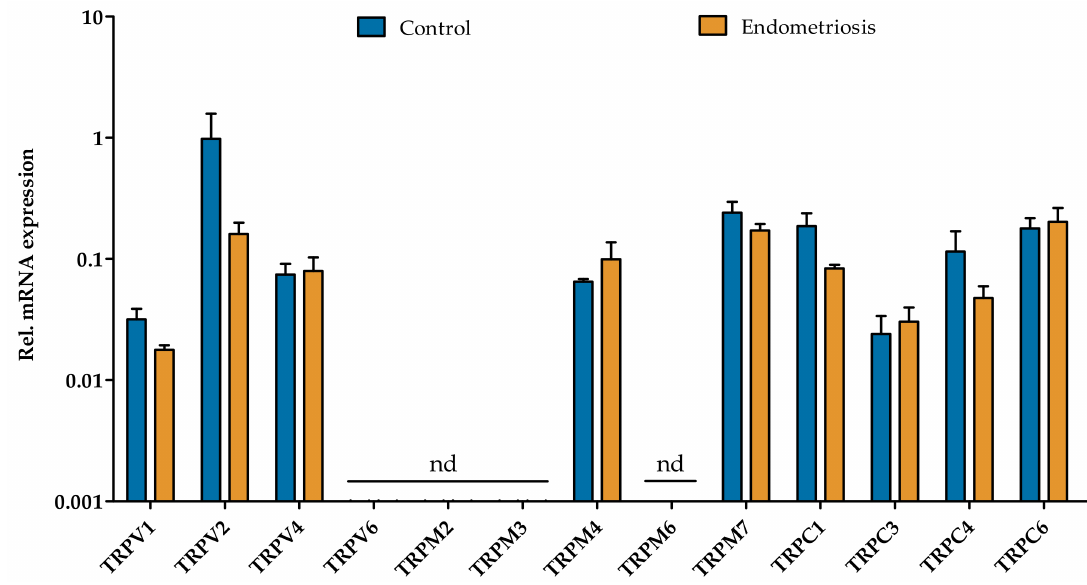
Figure 2. Quantitative RT-PCR of TRP channels in human endometrial stromal cells (hESC) derived from controls and endometriosis patients. Primary hESC were cultured from